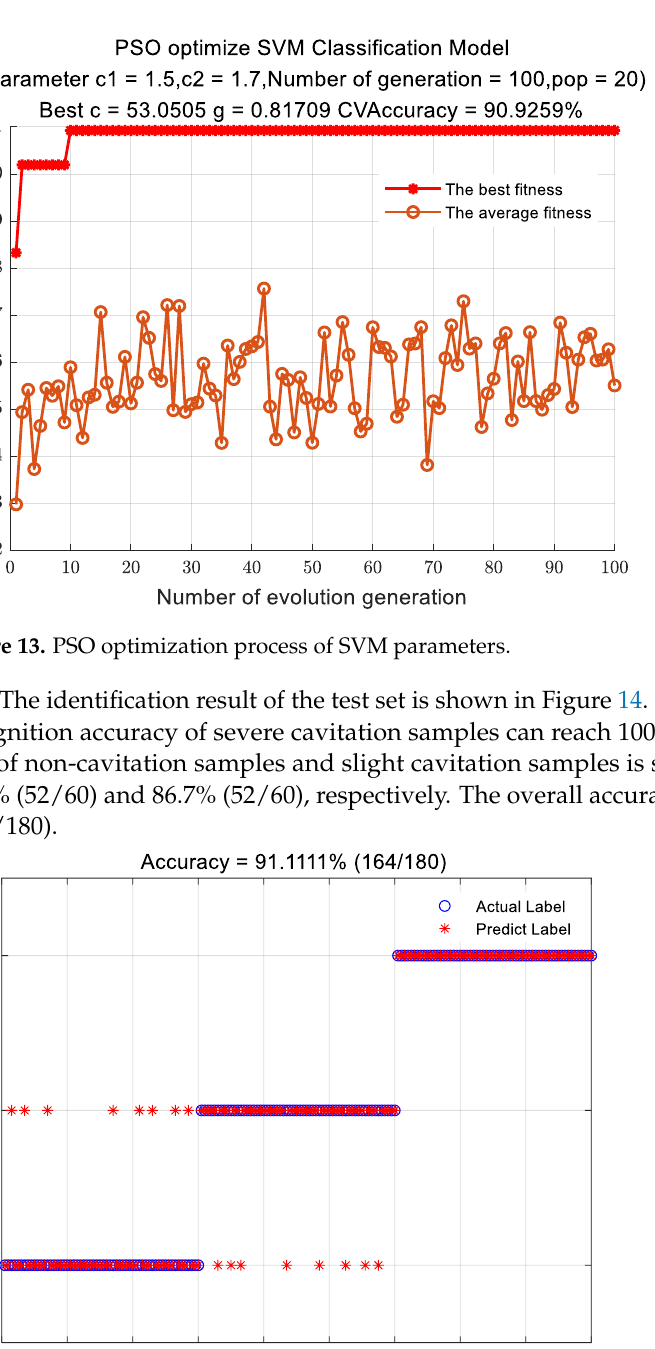
Figure 12. Identification accuracy with number of features selected by Relief-F.